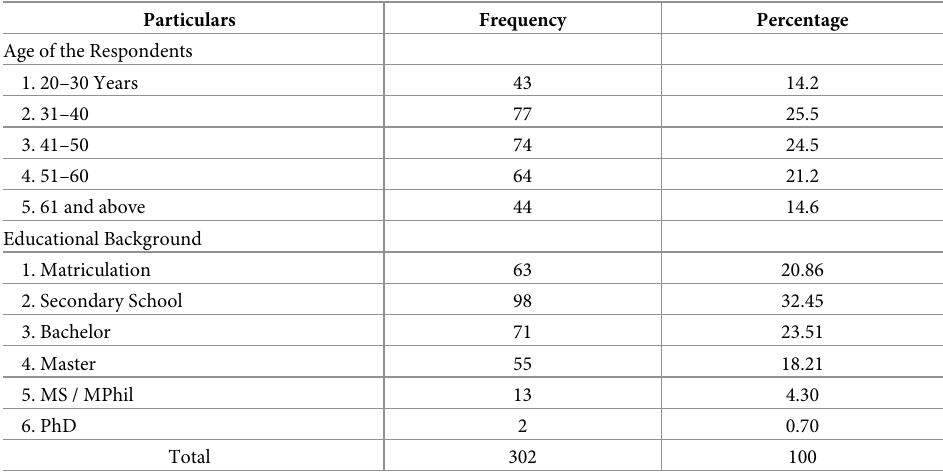
Table 1. Background detail of the rural